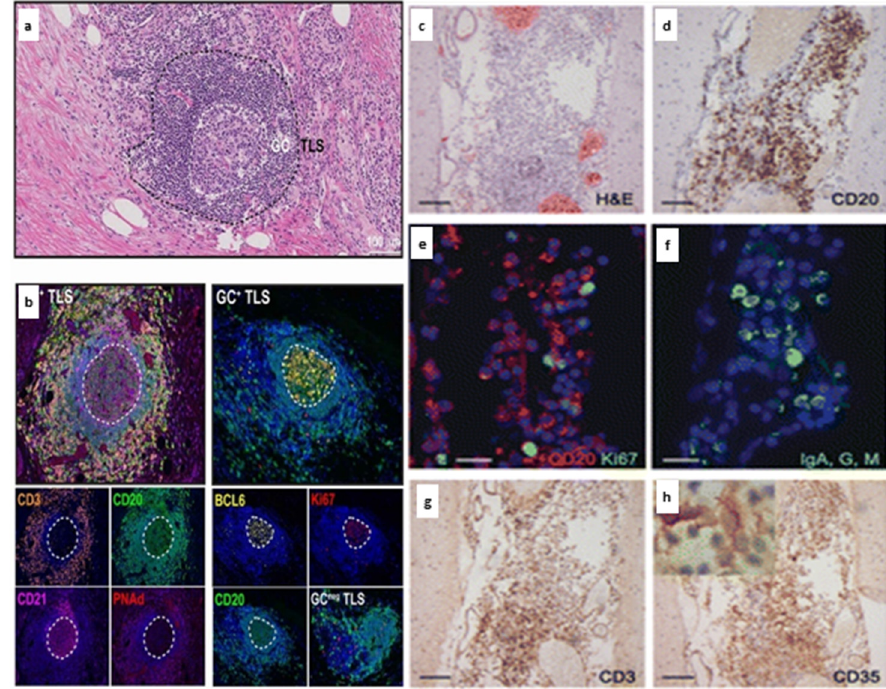
Figure 1. Tertiary lymphoid structures in cancer and multiple sclerosis [23,68]. Tertiary lymphoid structures (TLS) in pancreatic cancer demonstrate features reminiscent of secondary lymphoid organs with evidence of germinal centres ( a ), distinct B and T cell zones and PNAd + high endothelial venules ( b ). BCL6 + cells indicate germinal centre reactions and cells undergoing proliferation (Ki67 + ) are concentrated in the germinal centre ( b ). In comparison, meningeal TLS in MS typically demonstrate a loose aggregate of CD20 + B cells ( d ) interspersed with proliferating (CD20 + Ki67 + ) B cells ( e ), immunoglobulin A, G, M + plasma cells/plasmablasts ( f ), CD3 + T cells ( g ) and CD35 + follicular dendritic cells ( h ). Permissions: ( a , b ) Gunderson AJ et al. (2021) Germinal center reactions in tertiary lymphoid structures associate with neoantigen burden, humoral immunity and long-term survivorship in pancreatic cancer, OncoImmunology, 10:1, DOI: 10.1080/2162402X.2021.1900635 by permission of Taylor & Francis Ltd. www.tandfonline.com. Accessed on 18 July 2022. ( c – h ) Howell OW et al. Meningeal inflammation is widespread and linked to cortical pathology in multiple sclerosis. Brain 2011 134; 2755–2771 by permission of Oxford University Press. Accessed on 5 July